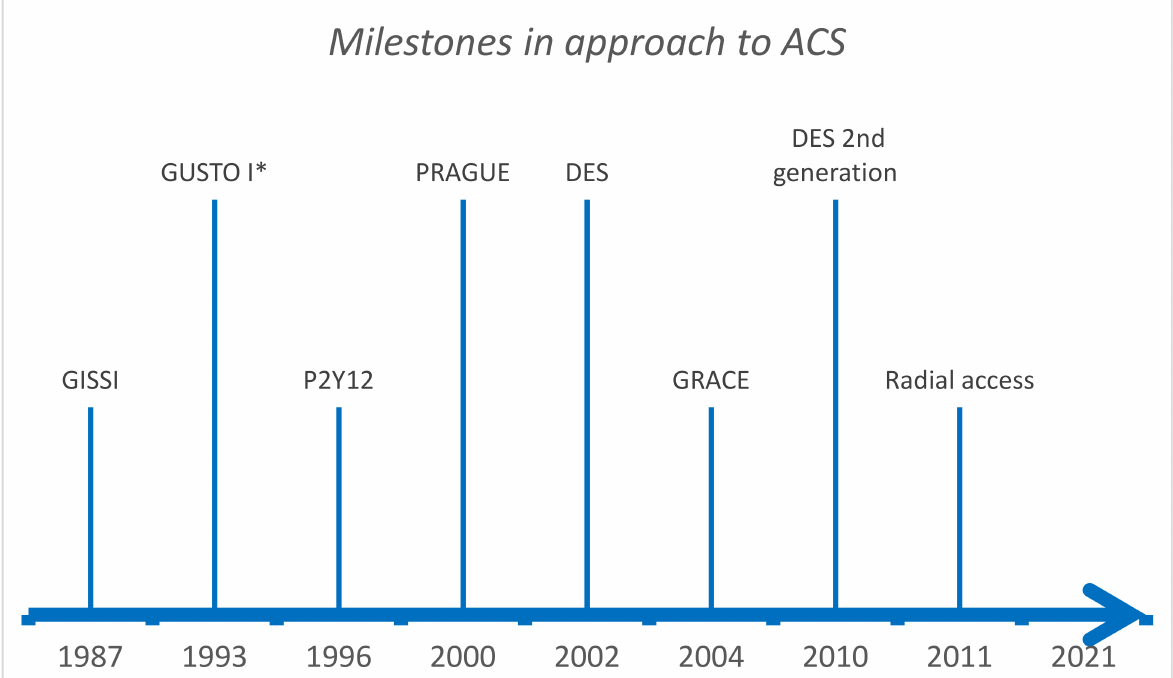
Figure 1. GISSI trial—fibrinolysis with streptokinase [69], GUSTO-I trial—fibrinolysis with alteplase (* same year benefit of PCI vs. streptokinase, 142 patients) [23,37], P2Y12—effectiveness of DAPT (Ticlopidine + Acetylsalicylic acid) over anticoagulation after PCI [70], PRAGUE study—benefit of transferring STE-ACS patient to PCI center [71], DES—drug eluting stents approved in Europe (1-year later in the USA) [72], GRACE—validated GRACE risk score [35], DES 2nd generation—higher efficacy everolimus eluting stent [73], Radial access—safer with less vascular complications vs. femoral access